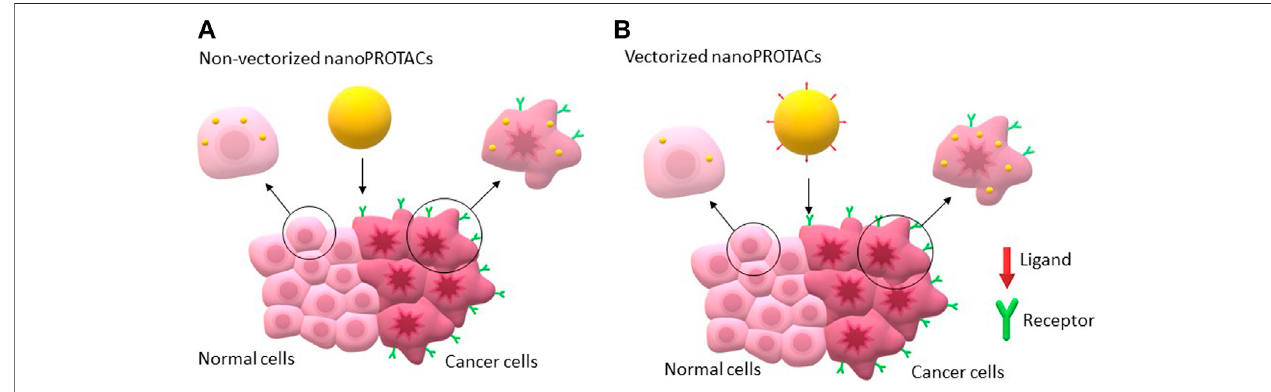
FIGURE 4 | Illustration of how vectorized and non-vectorized nanoPROTACs would act on cancer cells.